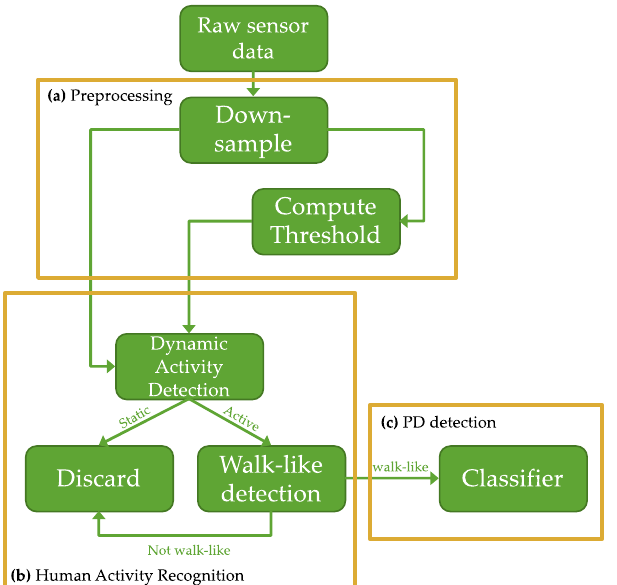
Figure 1. Block diagram of sensor-based PD detection pipeline: ( a ) preprocessing pipeline to down- sample the inertial data and calculate an adaptive threshold; ( b ) human activity recognition pipeline to parse the inertial data to dynamic activity and identify walk-like events from them; ( c ) deep convolutional neural PD classifier.